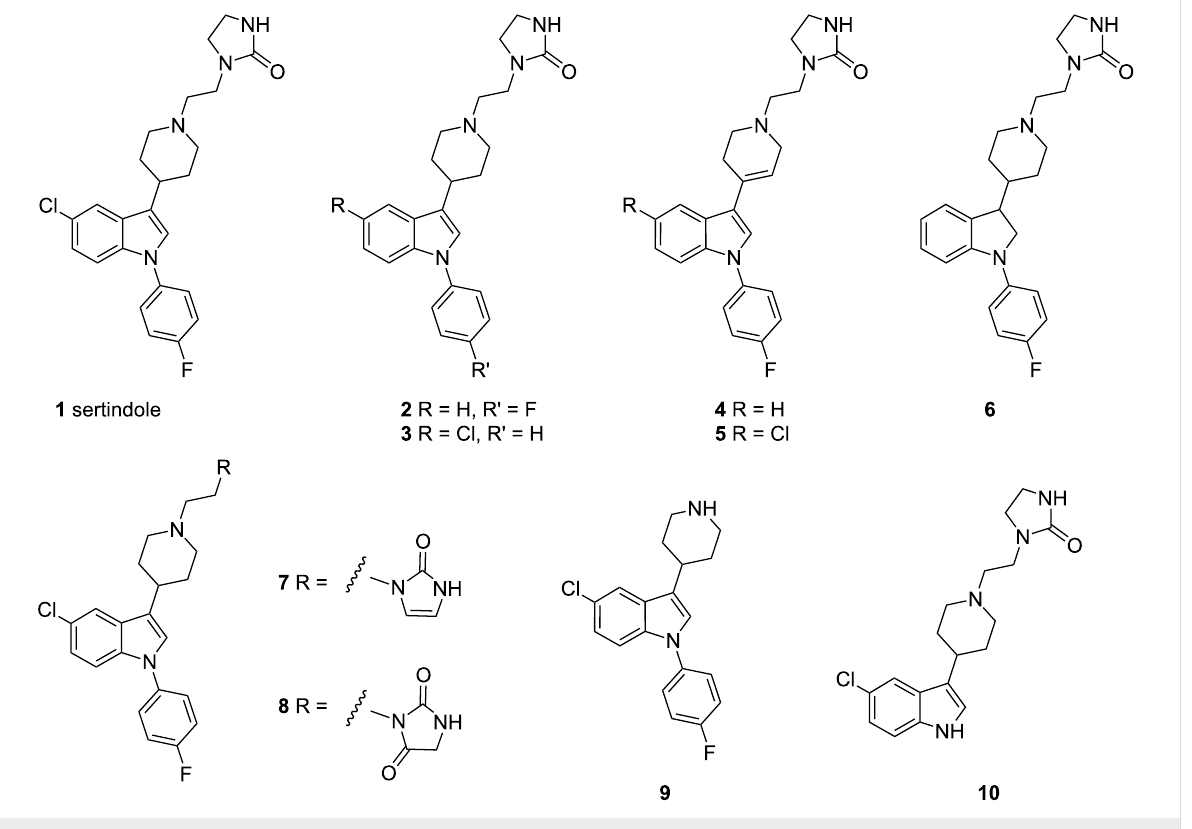
treatment of anxiety, hypertension, drug abuse and cognitive disorders. It has been reported to show antipsychotic effect in clinical studies. In contrast to other antipsychotics, sertindole has no associated sedative effects; sedation may add to the cognitive problems inherent in